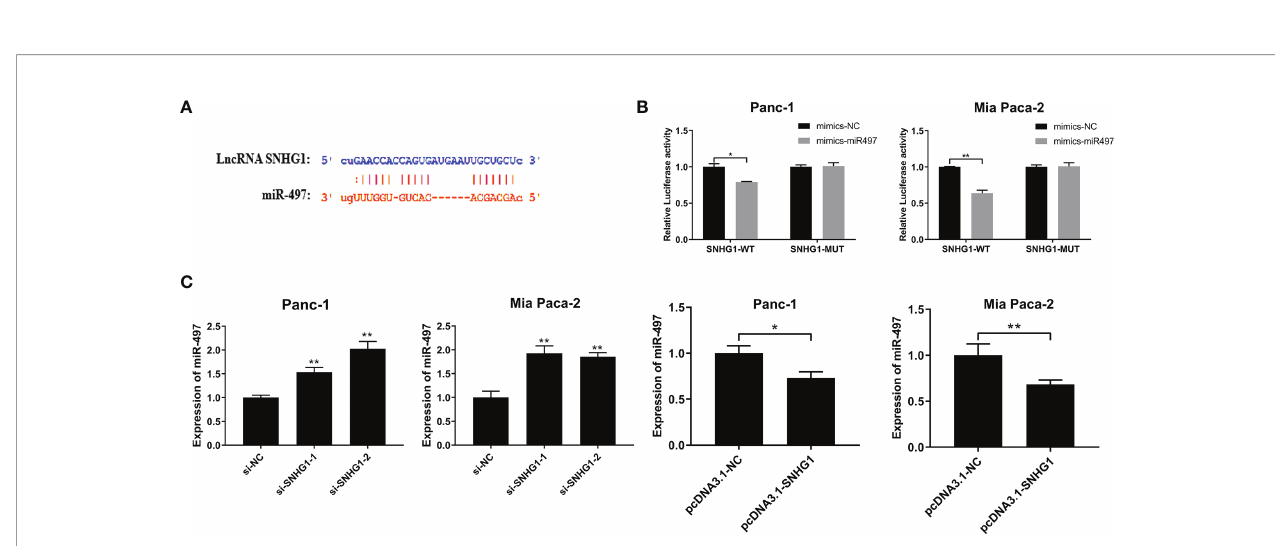
FIGURE 6 | SNHG1 sponges miR-497 and regulates miR-497 expression. (A) TargetScan prediction of miR-497-binding sites on SNHG1. (B) Luciferase activity in wild-type cells after transfection with miR-497 mimics. (C) miR-497 expression after cell transfection with si-SNHG1 or pcDNA3.1-SNHG1 assessed by qRT-PCR. *p < 0.05, **p <